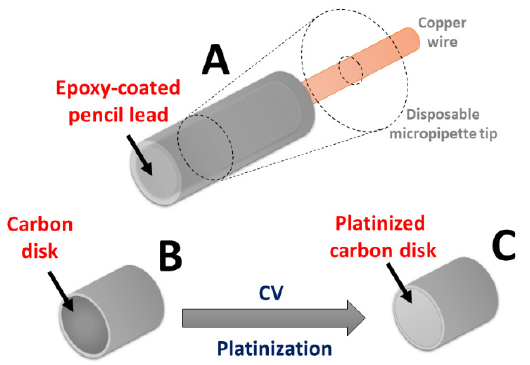
Figure 2. Scheme of the construction of the sensors obtained from pencil leads (PLs) platinized by means of CV technique. A: complete scheme of the sensor; B: carbon disk (0.3 mm Ø) obtained by inserting the PL in the micropipette tip; C: carbon disk platinized via CV best protocol.